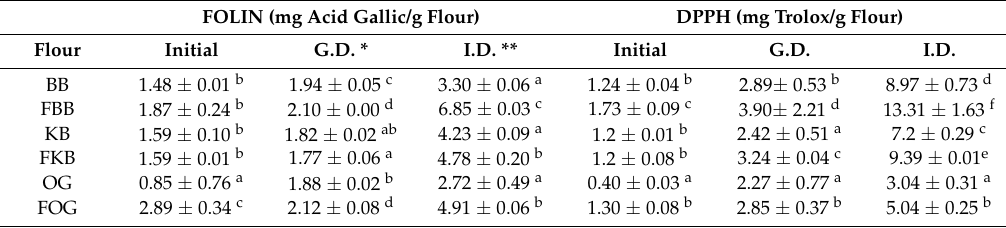
Table 2. Effect of Pleurotus ostreatus on antioxidant activity and total phenol content in different